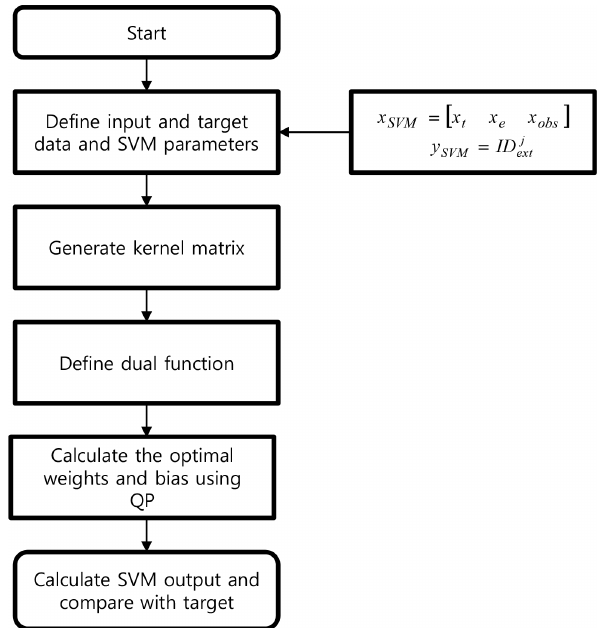
Figure 1. Flow chart of the SVM training